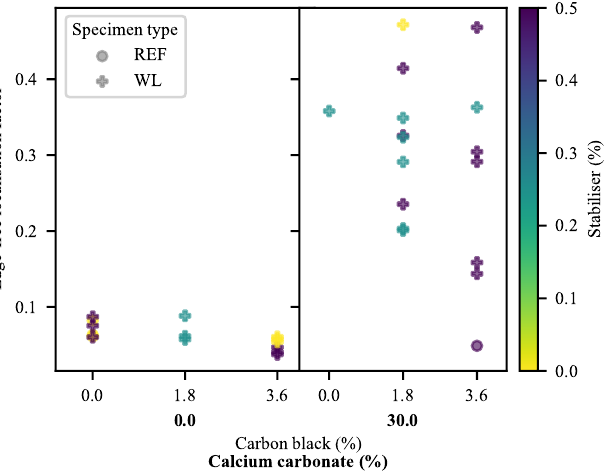
Figure 18. Extent of peak localisation as a function of specimen type and CC, CB and SP loadings.